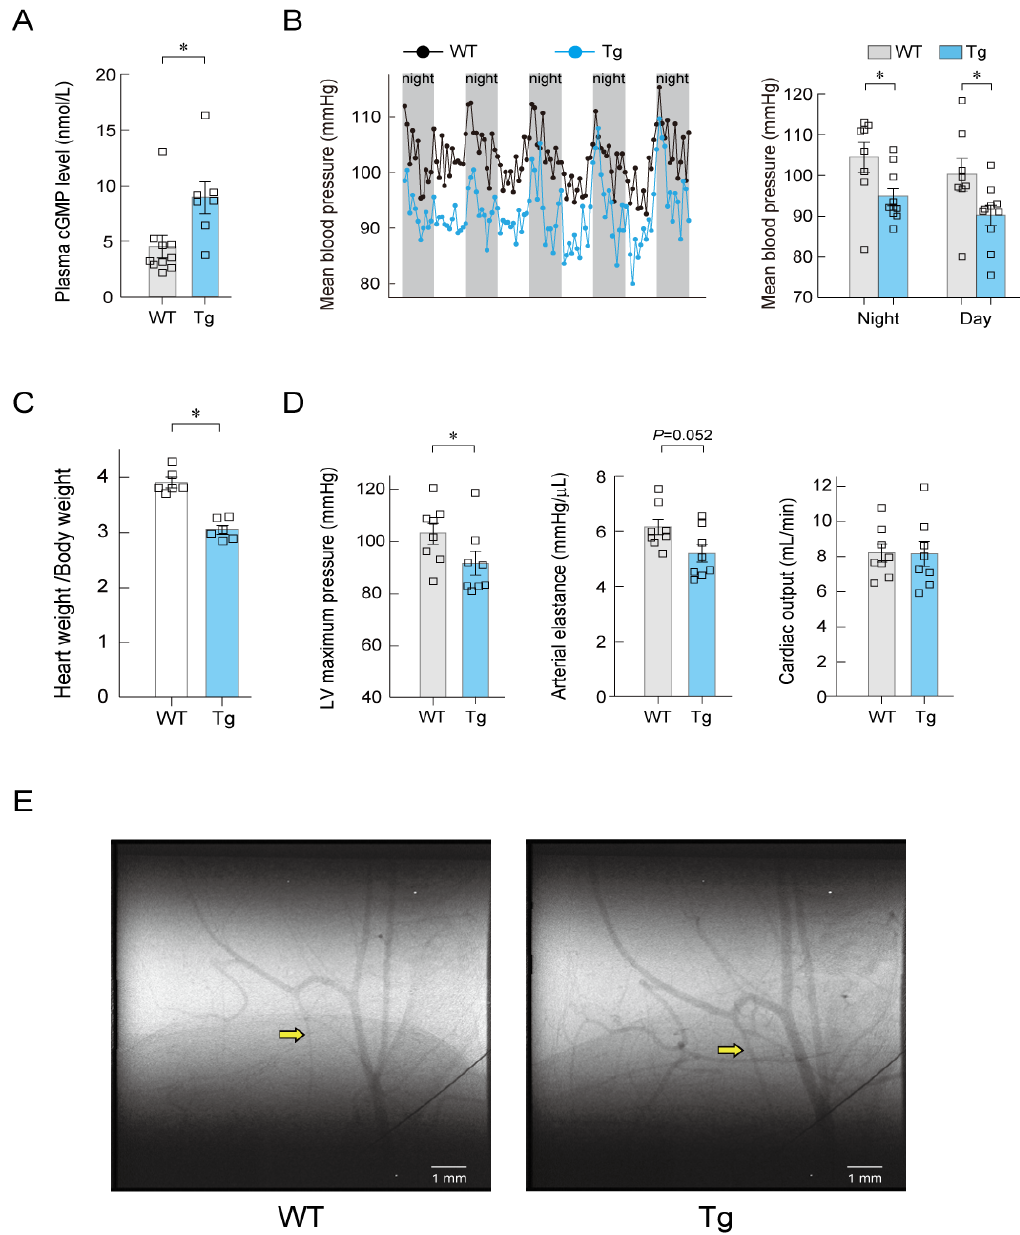
Figure 8. Endothelium-specific overexpression of GC-A results in hypotension and vasodilation in mice. ( A ) The plasma cyclic GMP level was higher in endothelial-cell-specific GC-A-overexpressing (Tg) mice than in wild-type (WT) mice. ( B ) The mean blood pressure, as determined by radiotelemetry, was significantly lower in the Tg mice than in the WT mice. ( C ) The heart weight to body weight ratio was significantly smaller in the Tg mice than in the WT mice. ( D ) Hemodynamic analysis revealed that the left ventricular (LV) maximum pressure and arterial elastance were lower in Tg mice than in the WT mice, but the cardiac output was comparable between the two types of mice. ( E ) Angiographic images from a WT mouse and a Tg mouse. Yellow arrows indicate a vessel that is dilated in the Tg relative to the WT. * p < 0.05. This figure is a reconstruction of the figure in our original article